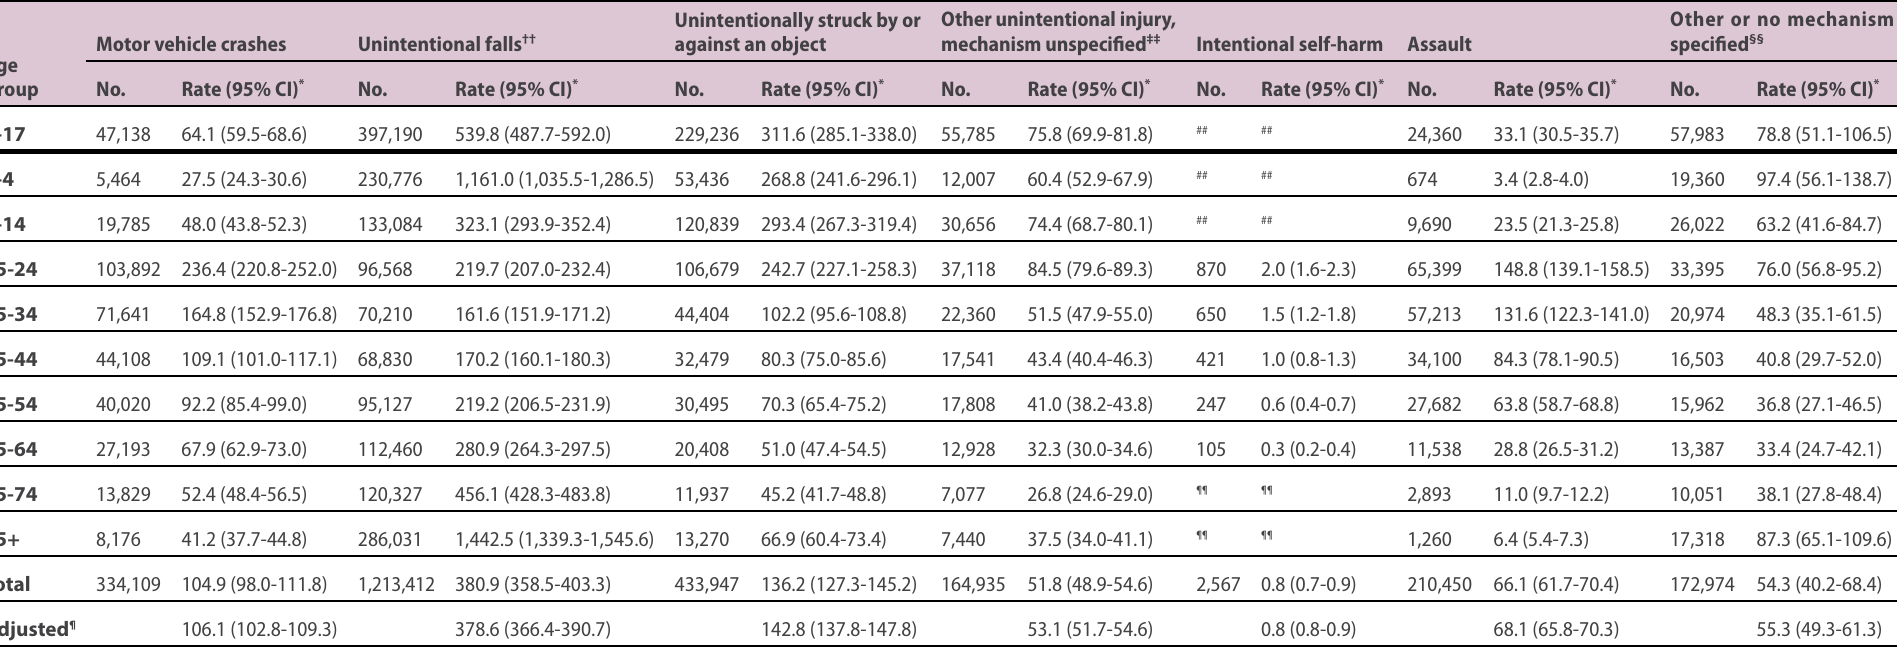
TABLE 2: ESTIMATED NUMBER AND RATE OF TRAUMATIC BRAIN INJURY–RELATED EMERGENCY DEPARTMENT VISITS, BY AGE GROUP AND MECHANISM OF INJURY, 2014